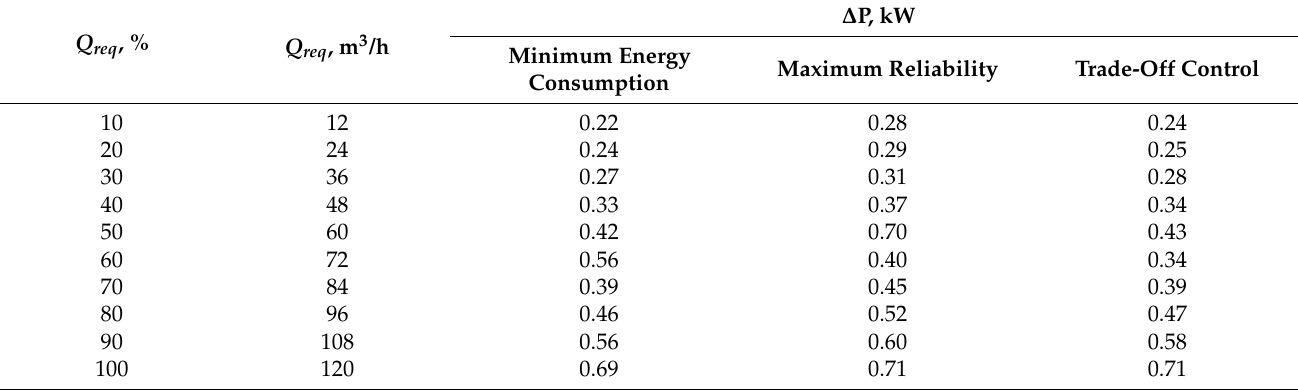
Table 6. Results of the loss calculation in the electric drive of the pump system applying the different control methods. Q req , %